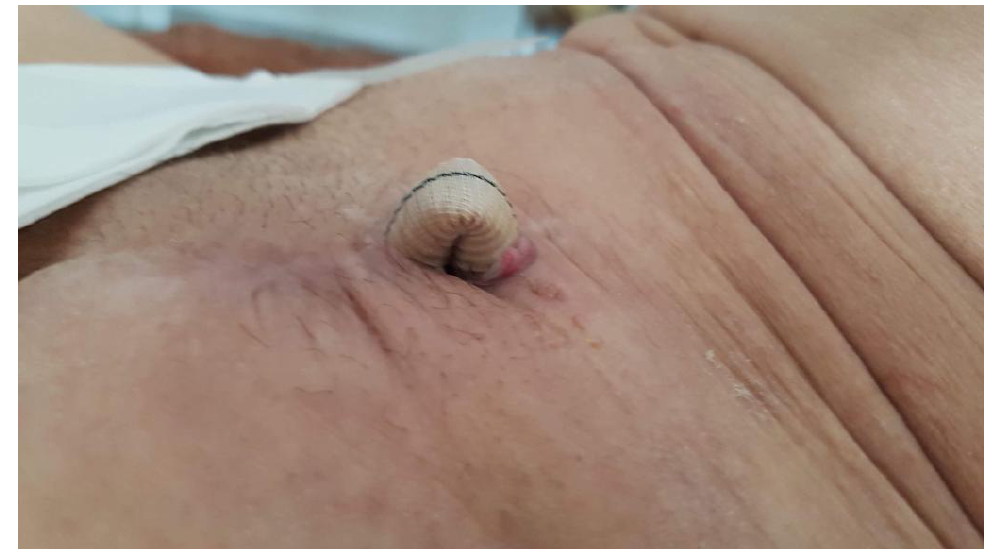
Figure 3. Exposed infected vascular graft.